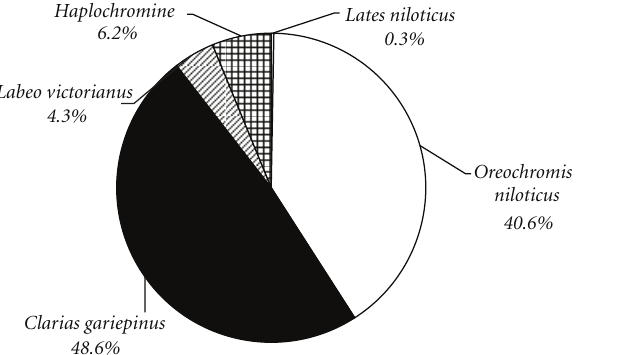
Figure 9: % composition of the fish species in the areas covered by water hyacinth complex.